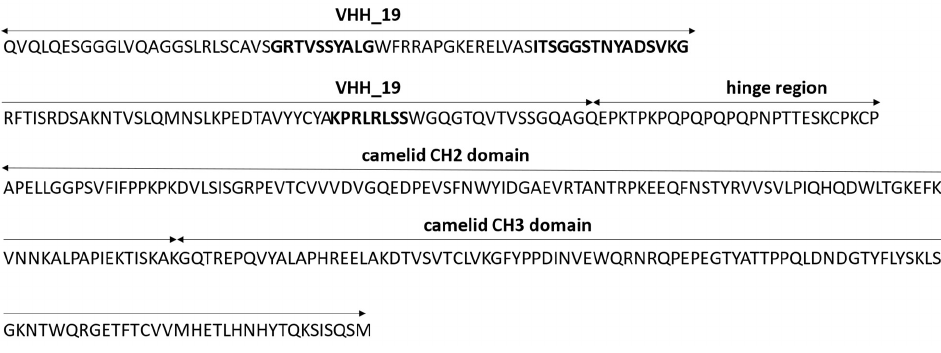
Figure 7. The amino acid sequence of the camelid recombinant full-length L19 antibody. The CDRs are highlighted in bold.